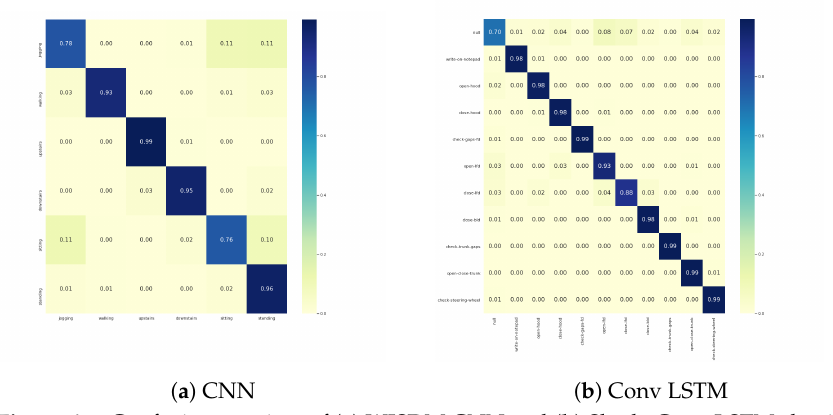
Figure A8. Confusion matrices of ( a ) WISDM CNN and ( b ) Skoda Conv LSTM